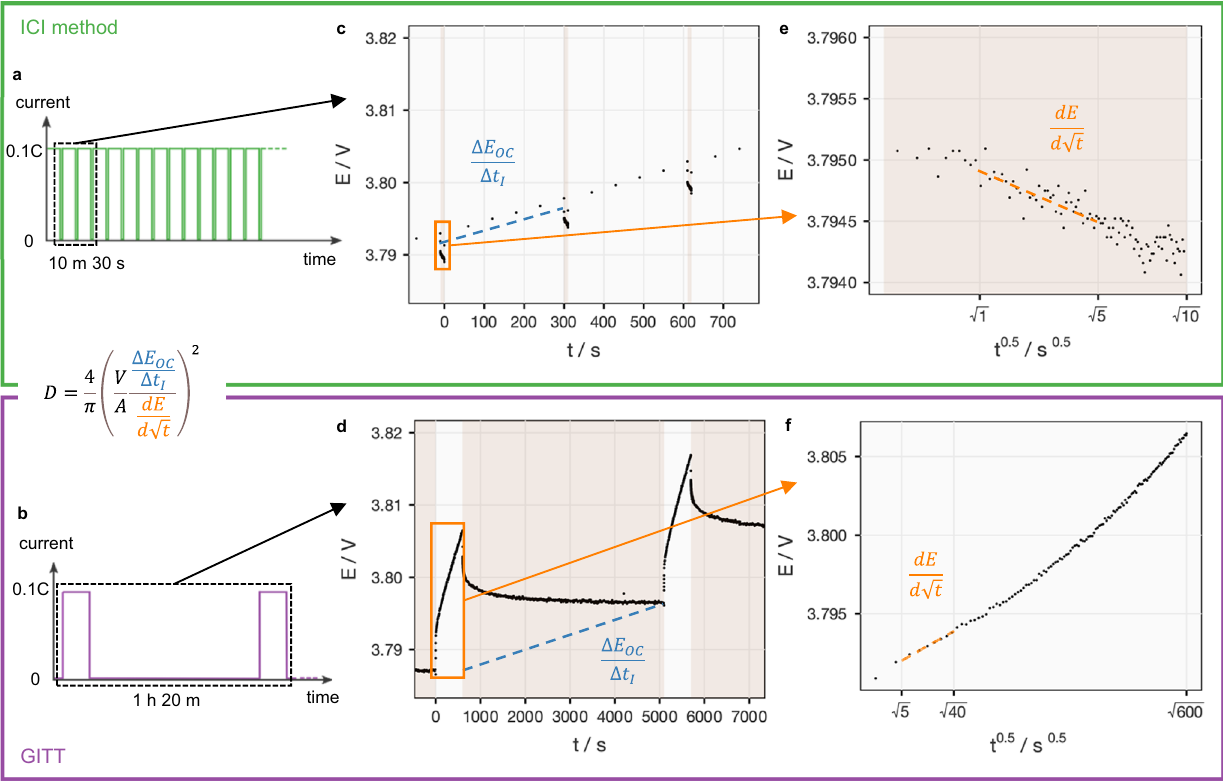
Fig.1|ComparisonbetweentheICIandtheGITTmethods.a , b Howthecurrent iscontrolledintheICImethodandtheGITTinthisworkonthesametesttimescale. c , d Electrodepotential( E )versussteptime( t )asaresponsefromthecurrentinput inthedashed-lineboxinaandb,respectively.Thebluedashedlineindicateswhere the slope of open-circuit potential against current-passing time ( Δ E OC / Δ t I ) is obtained. e , f Electrode potential ( E ) plotted against the square root of step time